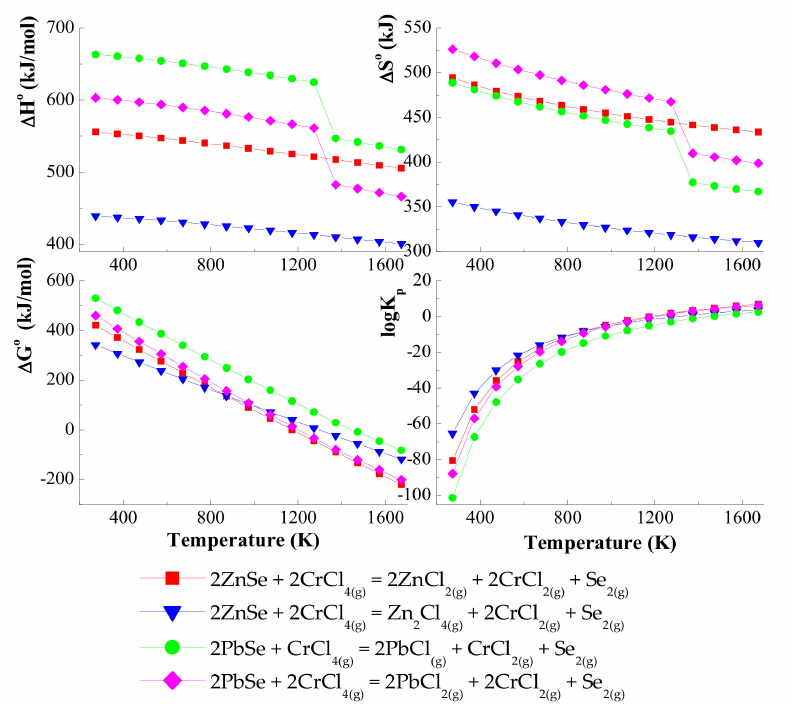
Figure 2. The dependence of the thermodynamic parameters vs. temperature T for the ZnSe and PbSe with CrCl 4 as a transport agent.